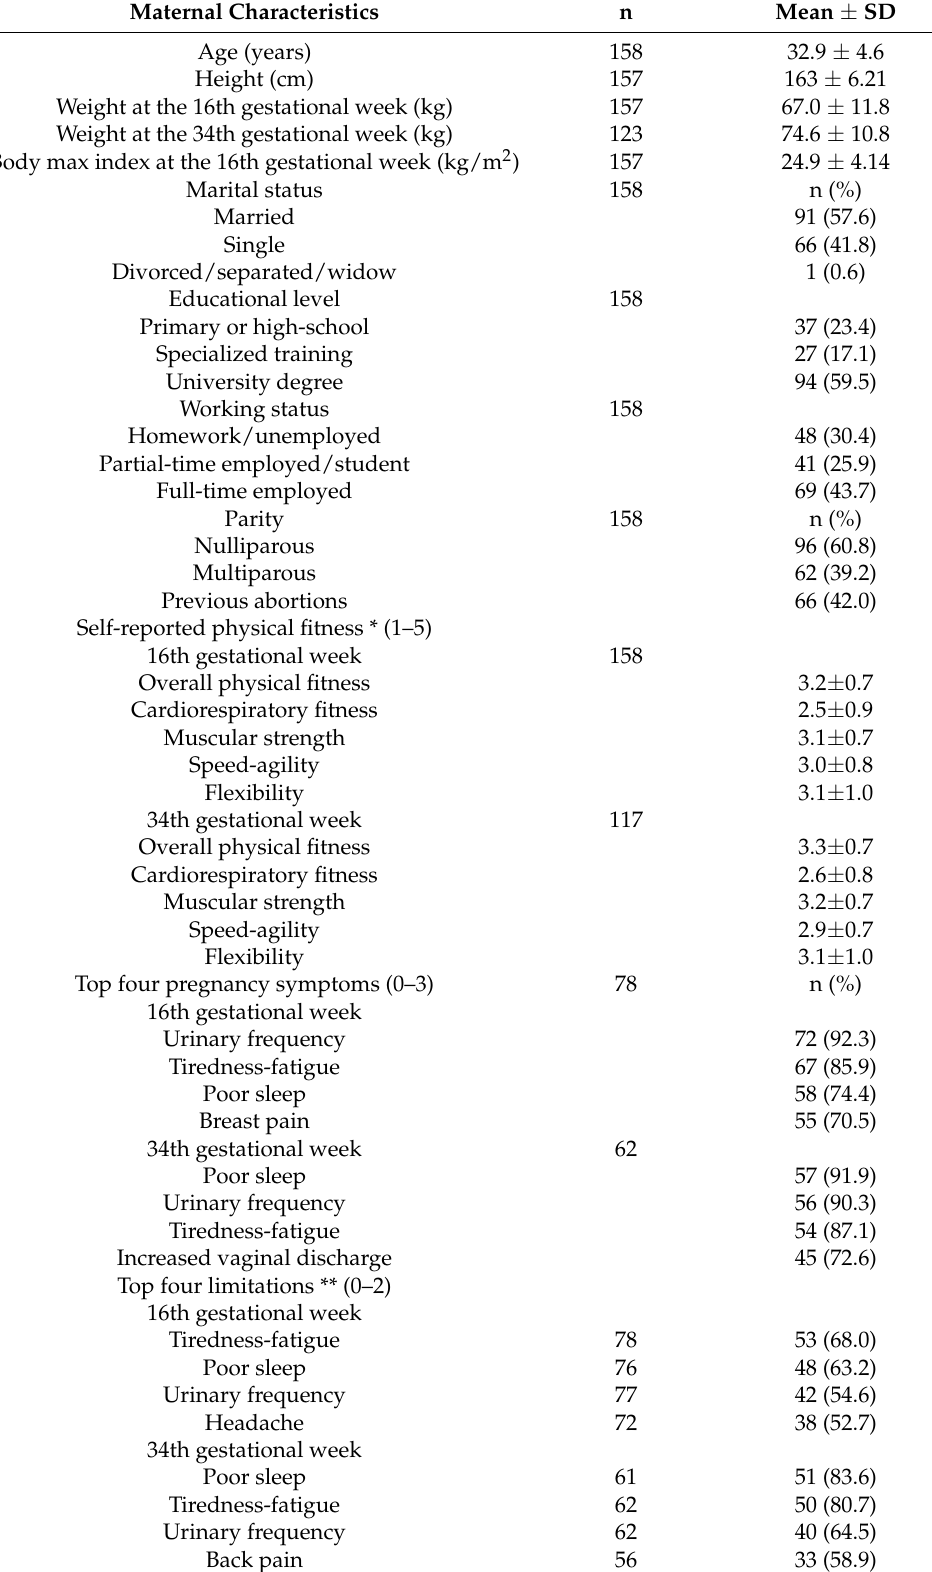
Table 1. Sociodemographic and clinical characteristics of the